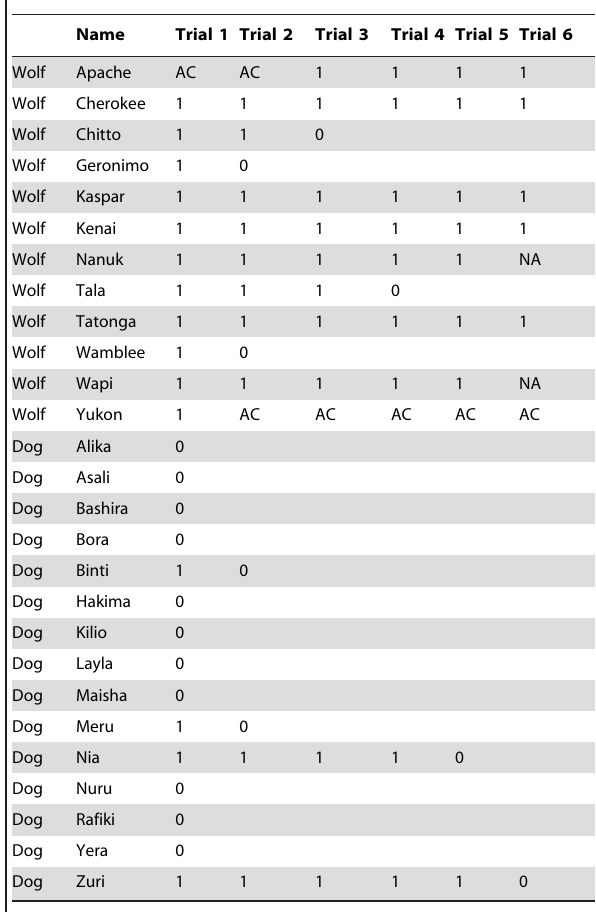
Table 2. Success of animals in the various trials.